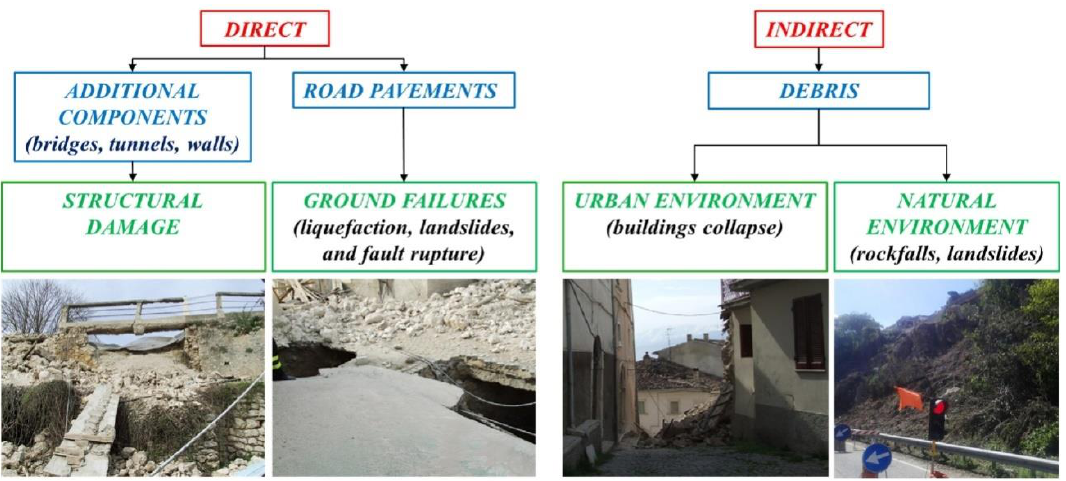
Figure 1. Types of road blockages.